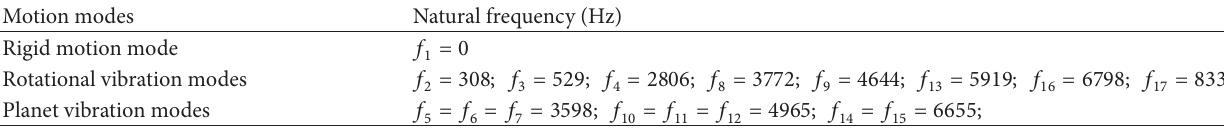
Table 4: Natural frequencies of planetary